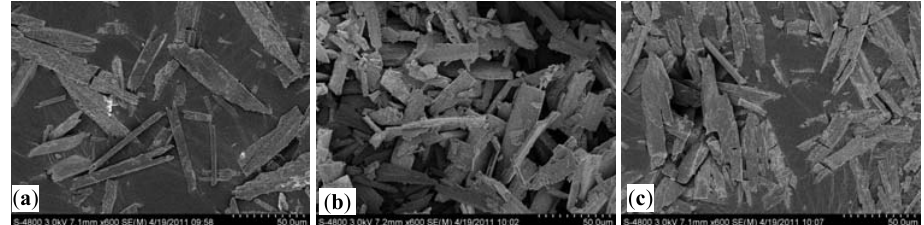
Figure 8. Morphology of struvite precipitation at various mixing times: ( a ) mixing time = 10 min; ( b ) mixing time = 20 min; ( c ) mixing time = 45